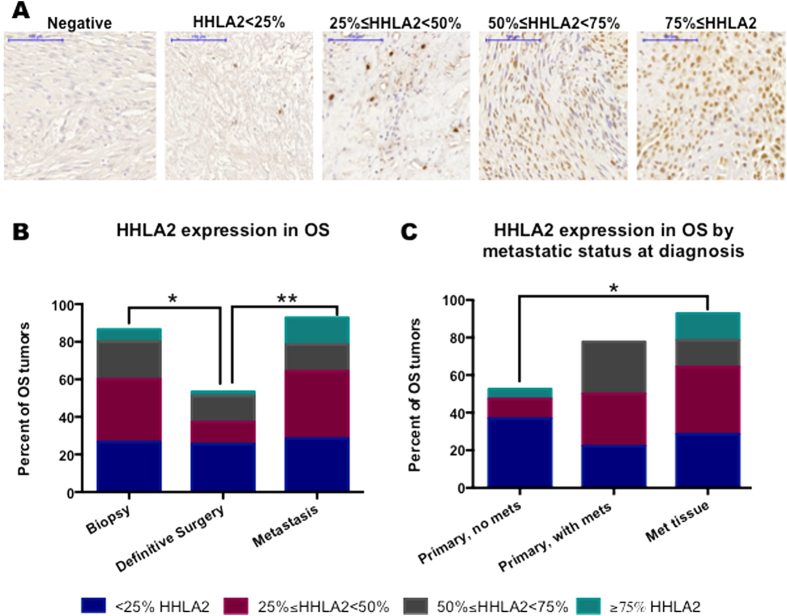
HHLA2 is expressed in the majority of osteosarcoma tumors.(A) representative tumors for each HHLA2 grade based on IHC. The ICH scores were based on the percentage of tumor cells that were HHHLA2 positive, with the five subdivisions being: negative, less than 25% positive, 25% ≤ HHLA2 < 50%, 51% ≤ HHLA2 < 75%, and equal or greater than 75% positive. Scale bar, 100 μM. (B) The majority of tumors examined were HHLA2 positive at all times of diseases progression. There is a significant decrease in HHLA2 positive cells between the time of biopsy and definitive surgery (77% vs 53%, p = 0.03). Metastatic samples have a higher percentage of cells staining positive for HHLA2 when compared to samples at definitive surgery (93% vs 53%, p = 0.01) and at biopsy (93% vs 77%, p = 0.001). (C) HHLA2 expression was sorted into three groups based on tissue type and presence of metastasis: primary tissue with metastasis, primary tissue without metastasis, and metastatic tissue. The percentage of cells expressing HHLA2 is significantly increased in metastatic tissue compared to primary tissue without presence of metastatic disease (53% vs 93%, p = 0.02).